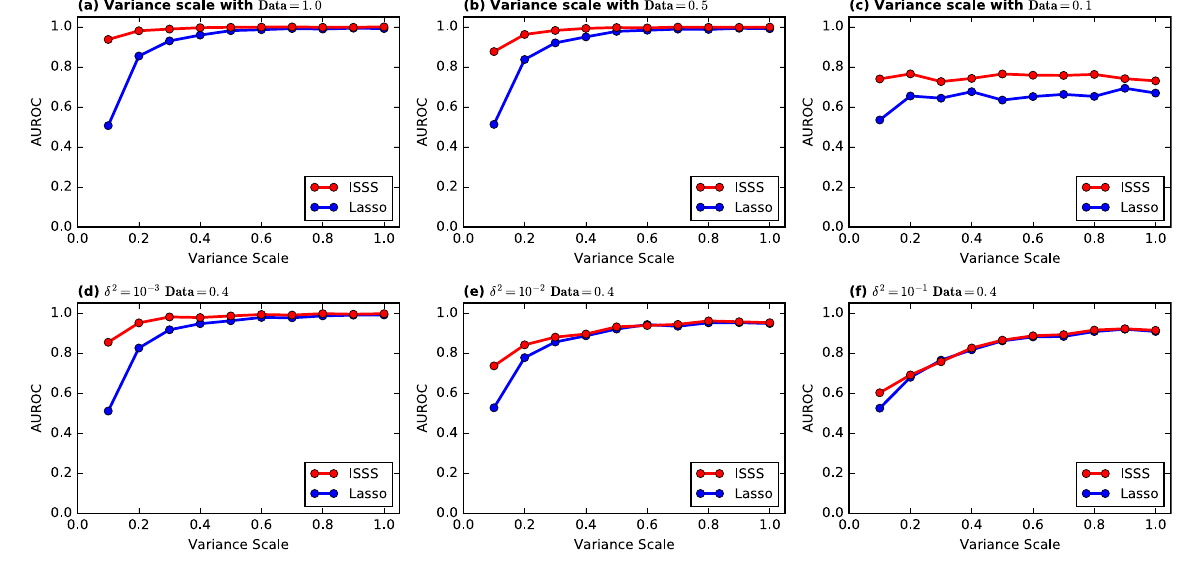
Figure 3. Insufficient data vs variance scale. In most cases, the AUROC of ISSS and Lasso rises, as the variance increases. With small variance, ISSS performs much better than the Lasso. With Data = 0.1, the performance cannot be improved with any variance. It indicates that insufficient data plays an important role in the inference task. Extremely insufficient data leads to the failure of all the methods. The experimental results with other Data ∈ [0.2, 1] values are similar. In this section, we take Data = 0.4 as a representative. As shown in this figure, with small noise, ISSS outperforms Lasso. With great noise, the performance of ISSS and Lasso reach the upper bound of the model. Hence the performance of the two methods are the same.